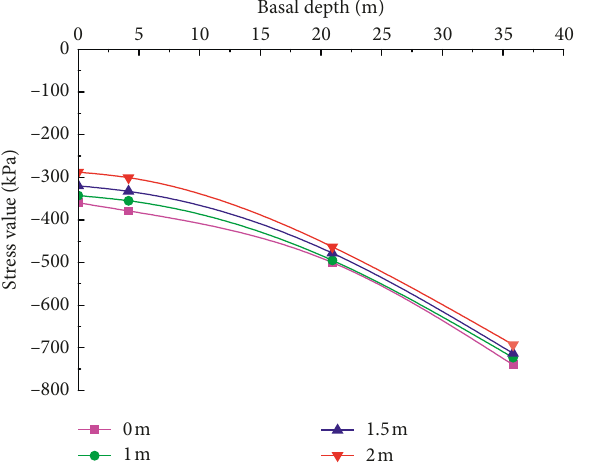
Figure 9: The vertical stress curve of the axis of the base. 0